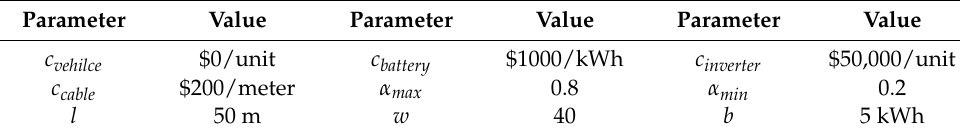
Table 3. System parameters for problem